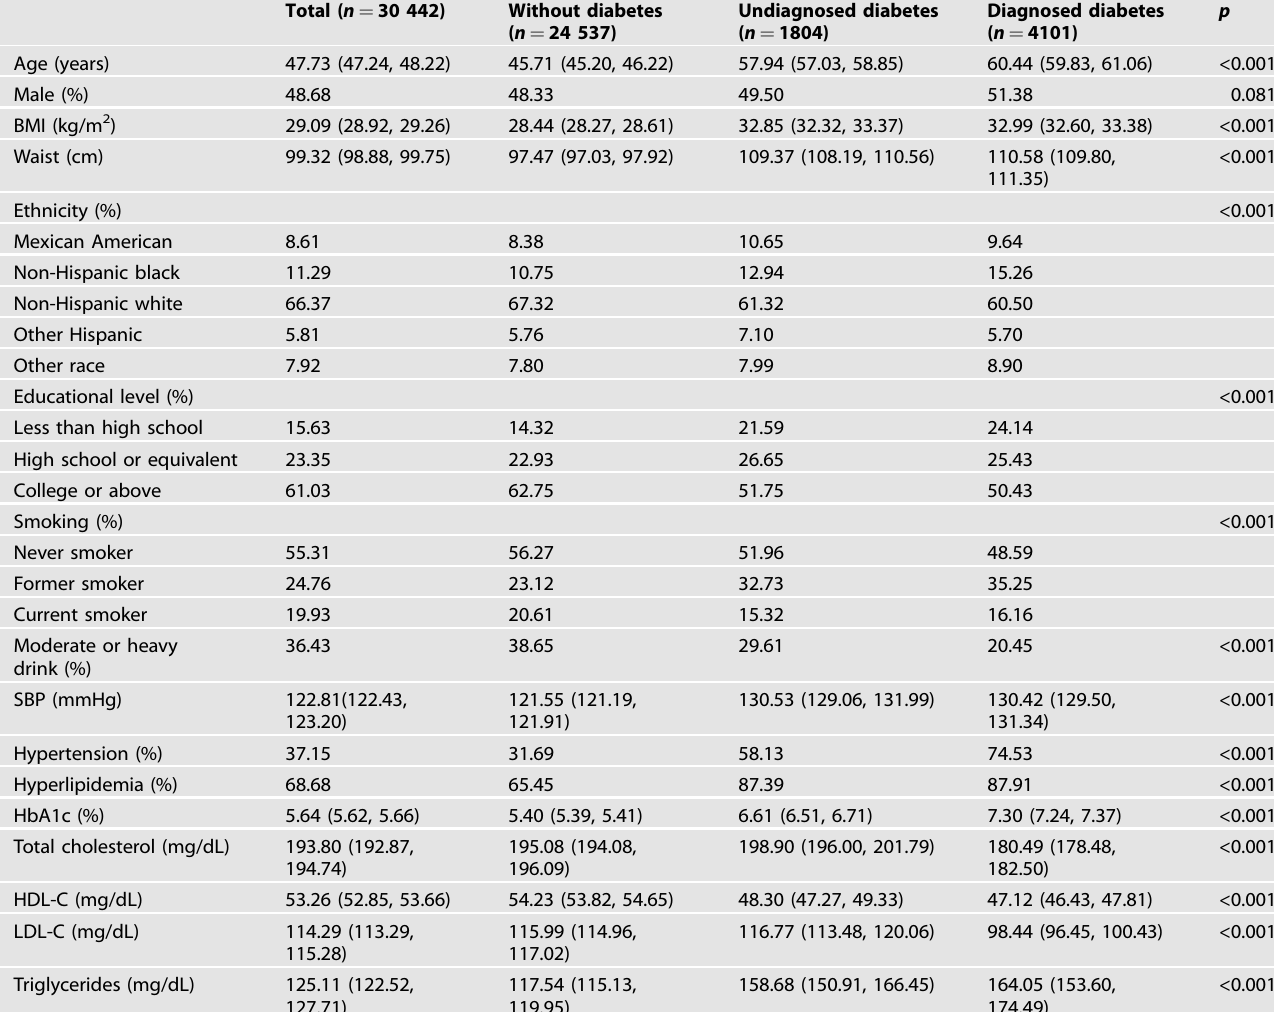
Table 1. Baseline characteristics according to diabetes diagnoses. Total ( n = 30